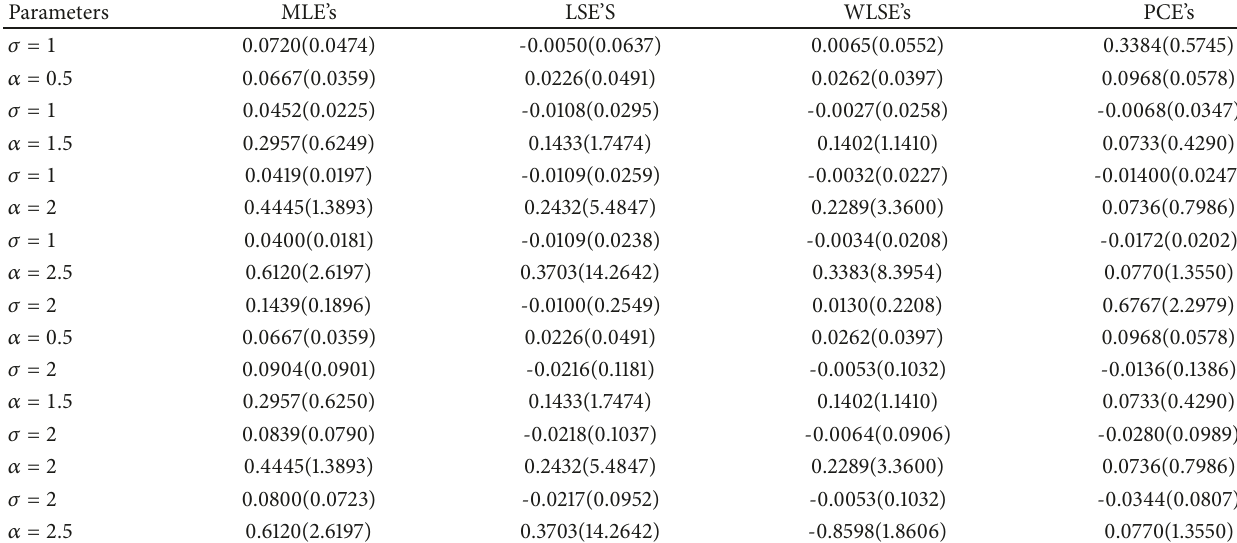
Table 1: Average bias values of estimates and their MSE (in brackets) when n=20.